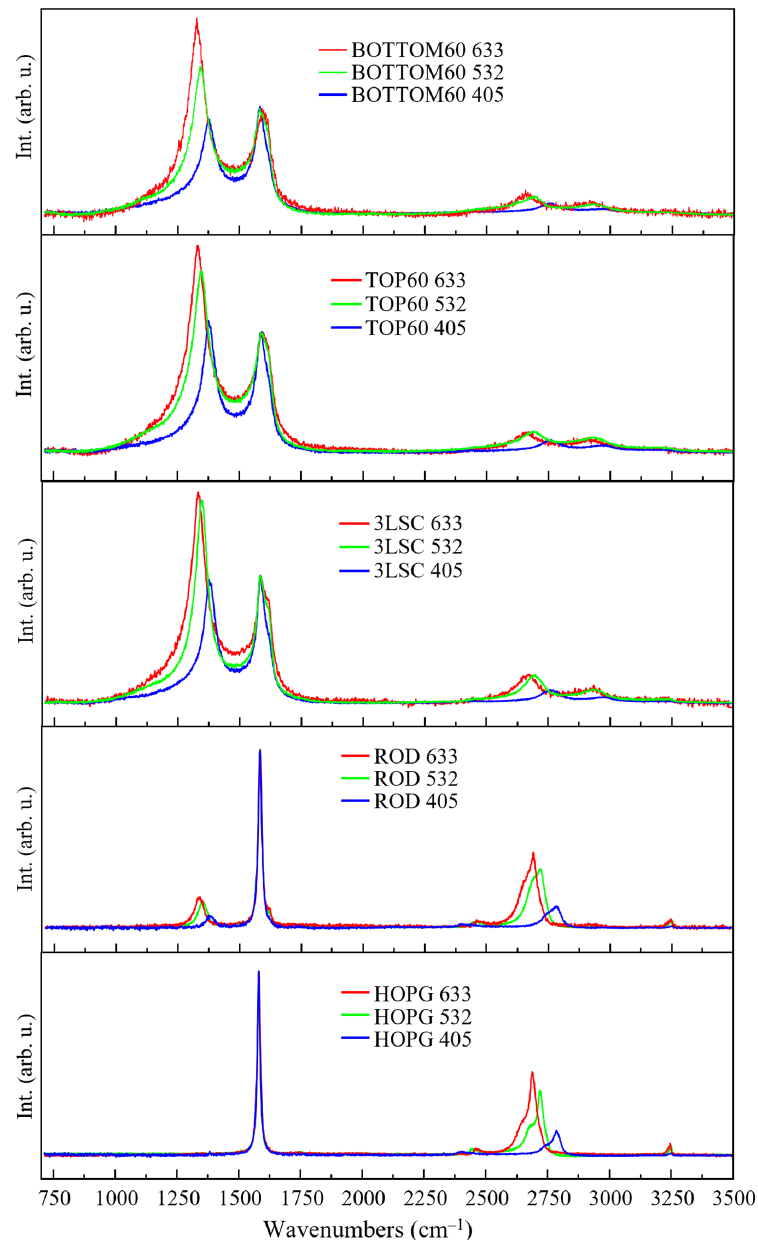
Figure 12. Multiwavelength Raman spectra ( λ exc = 633, 532, 405 nm) of: TOP60, BOTTOM60, 3L/SC, ROD, HOPG